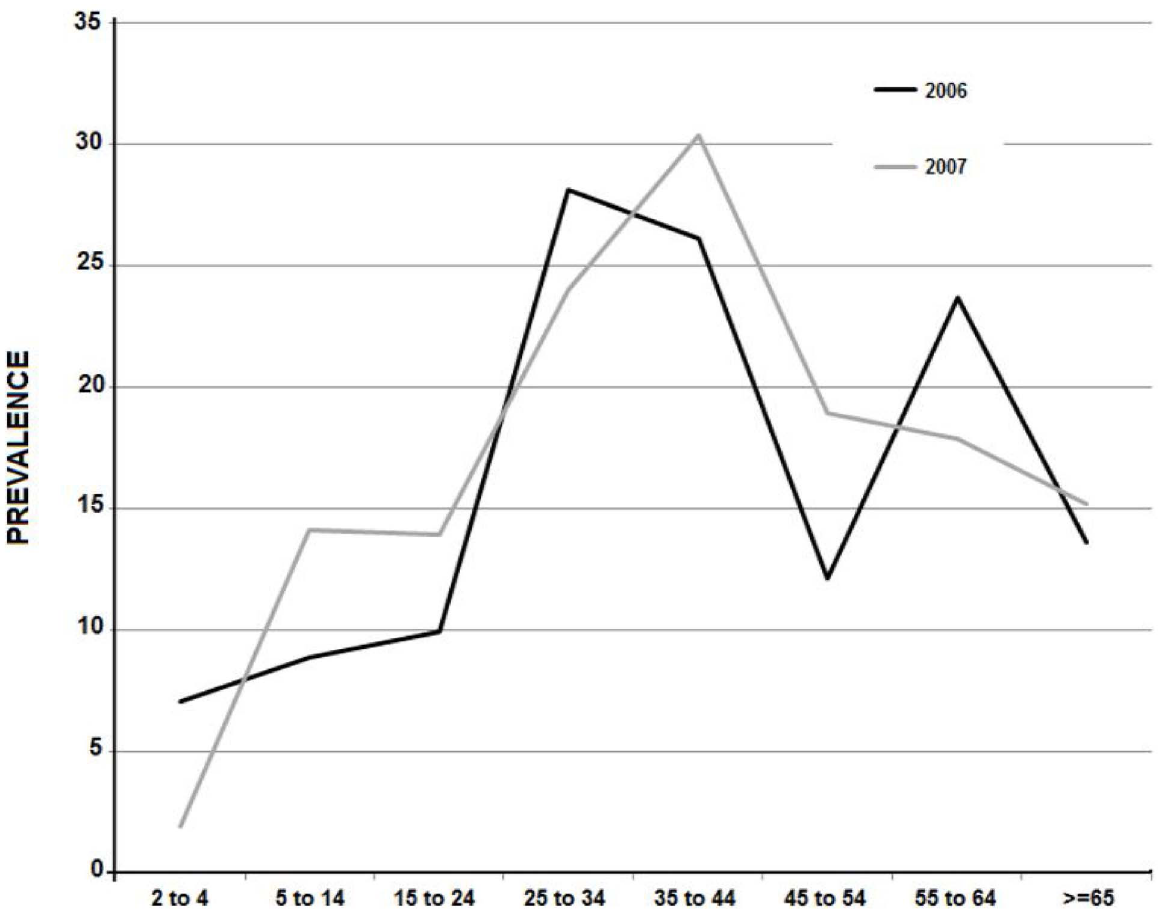
Figure 3. Prevalence of epilepsy stratified by age in 58 rural communities during the population based-studies interventions in 2006 (region A) and 2007 (region B).